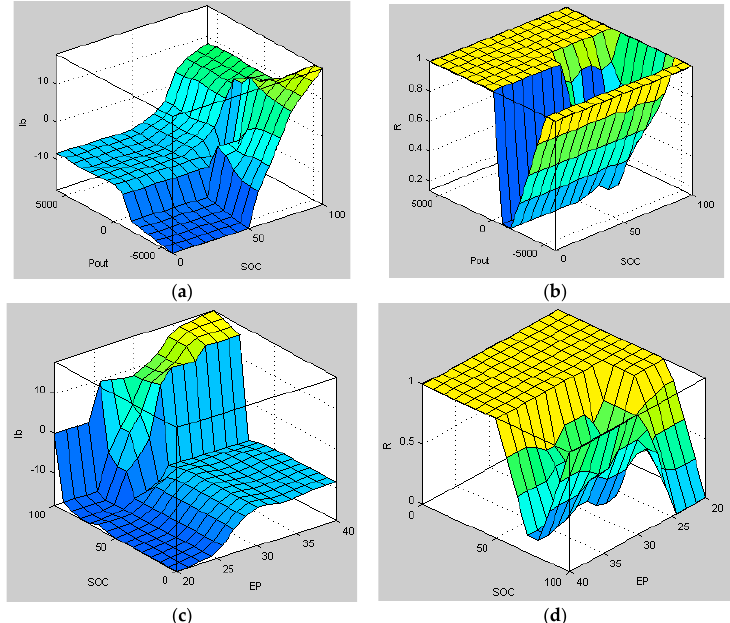
Figure 5. Fuzzy surfaces between inputs and outputs: ( a ) ESS current (Ib) as function of power dif- ference (Pout) and SOC; ( b ) grid external relay (R) as a function of power difference (Pout) and SOC; ( c ) ESS current (Ib) as a function of SOC and electricity price (EP); and ( d ) grid external relay (R) as a function of SOC and electricity price (EP).